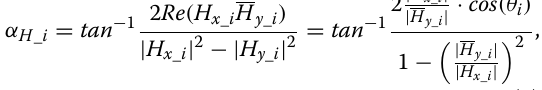
Fig. 2. The sampling period of this survey is 5 s. The data